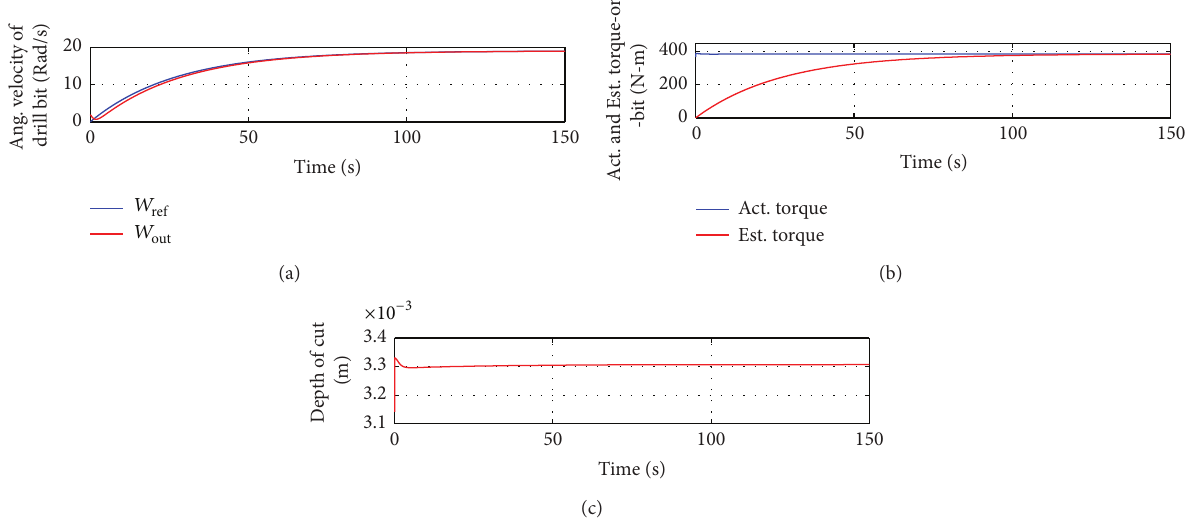
Figure 14: Response of rotational velocity 𝜔 1 (𝑡) (a), torque-on-bit 𝑇(𝑡) versus estimated torque-on-bit for 𝑊 0 = 2500 N, 𝜖 = 20 MPa, and 𝛾 0 = 10 8 .